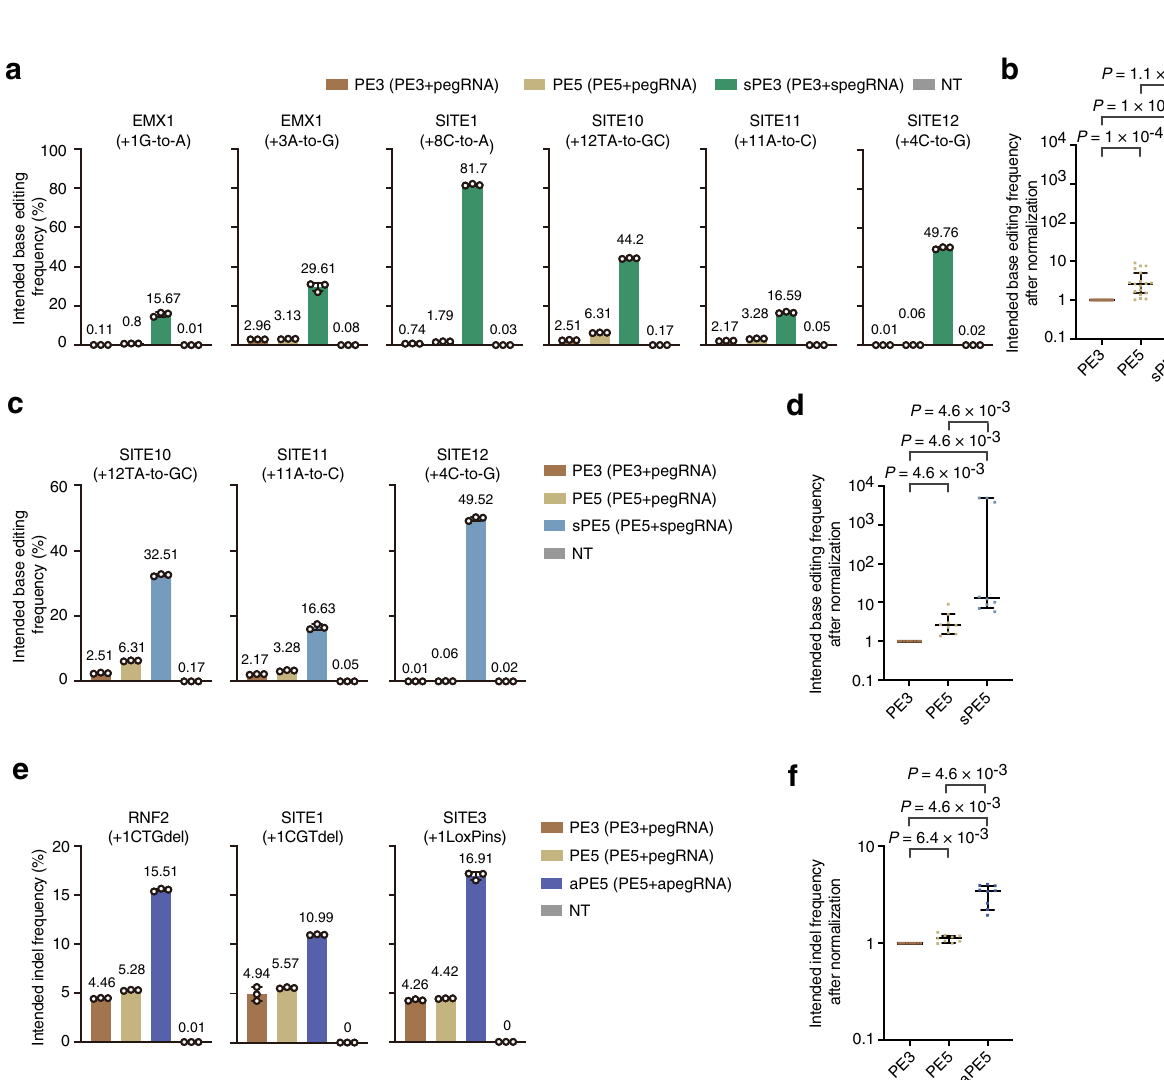
Fig. 3 Comparison and combination of PE5, spegRNA, and apegRNA. a Comparison of PE5 with spegRNA. The intended base editing frequencies were induced by PE3, PE5, and sPE3 (PE3 with spegRNA) at the indicated target sites. b Statistical analysis of normalized base editing frequencies induced by PE3, PE5, and sPE3, setting the frequencies induced by PE3 as 1. n = 18 intended base editing from three independent experiments in a . c Combination of PE5 and spegRNA. The intended base editing frequencies were induced by PE3, PE5, and sPE5 (PE5 with spegRNA) at the indicated target sites. The data for PE3 and PE5 are same as the ones in a . d Statistical analysis of normalized base editing frequencies induced by PE3, PE5, and sPE5, setting the frequencies induced by PE3 as 1. n = 9 intended base editing from three independent experiments in c . e Combination of PE5 and apegRNA. The intended indel frequencies were induced by PE3, PE5, and aPE5 (PE5 with apegRNA) at the indicated target sites. f Statistical analysis of normalized intended indel frequencies induced by PE3, PE5, and aPE5, setting the frequencies induced by PE3 as 1. n = 9 intended indel editing from three independent experiments in e . a , c , e Means ± s.d. are from three independent experiments. b , d , f P value, Wilcoxon one-tailed signed-rank test. The median and interquartile range (IQR) are shown. Source data are provided as a Source Data fi